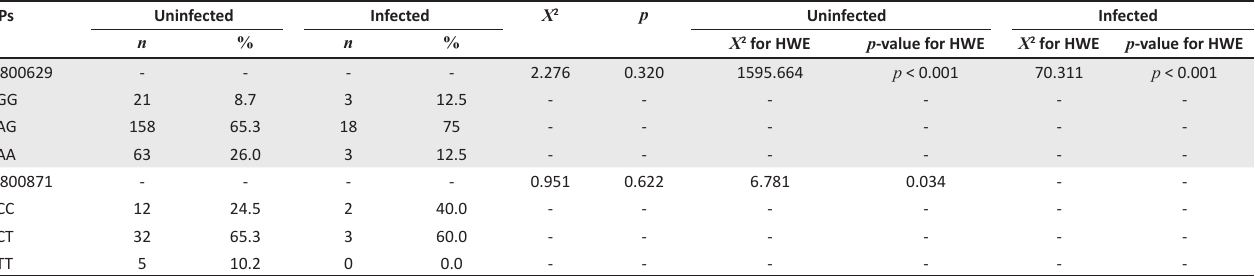
TABLE 2: Genotype distributions of TNF- α (rs1800629) and IL-10-819 T>C (rs1800871) between S. haematobium infected and uninfected preschool children from Madziwa, Shamva district, Zimbabwe, September 2018.